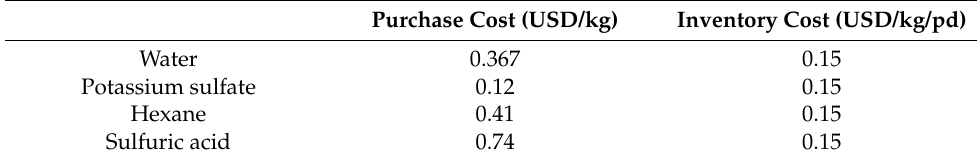
Table A2. Purchase and inventory costs for each recoverable material [18].